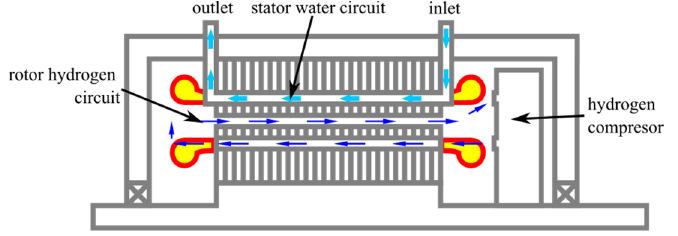
Figure 24. Hybrid cooling system for 1992 MVA turbogenerator (water + hydrogen gas) [114].